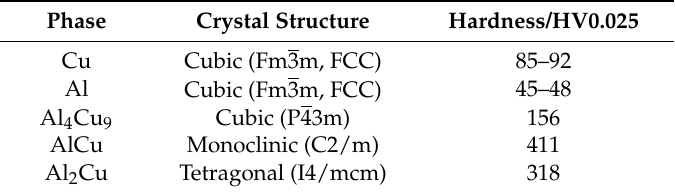
Table 5. Some characteristics of Cu, Al, Al 4 Cu 9 , AlCu, and Al 2